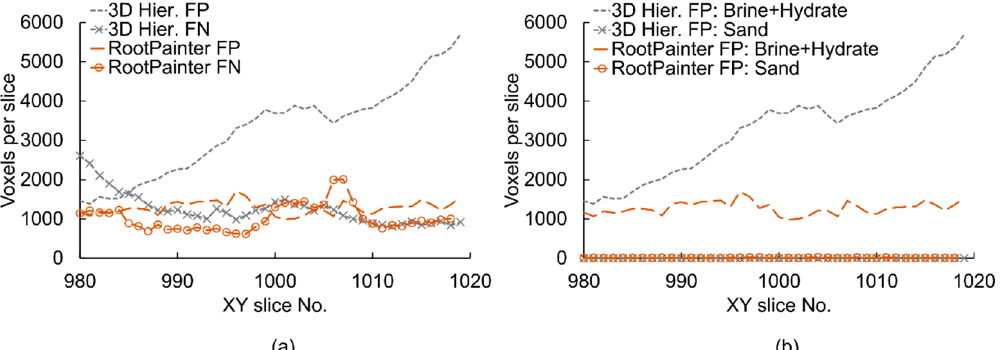
Figure 9. ( a ) False positive (FP) and false negative (FN) CH 4 gas voxels and ( b ) FP voxel labels per slice for the central 40 slices of dataset LC03 segmented using RootPainter and the 3D hierarchical method (3D Hier).